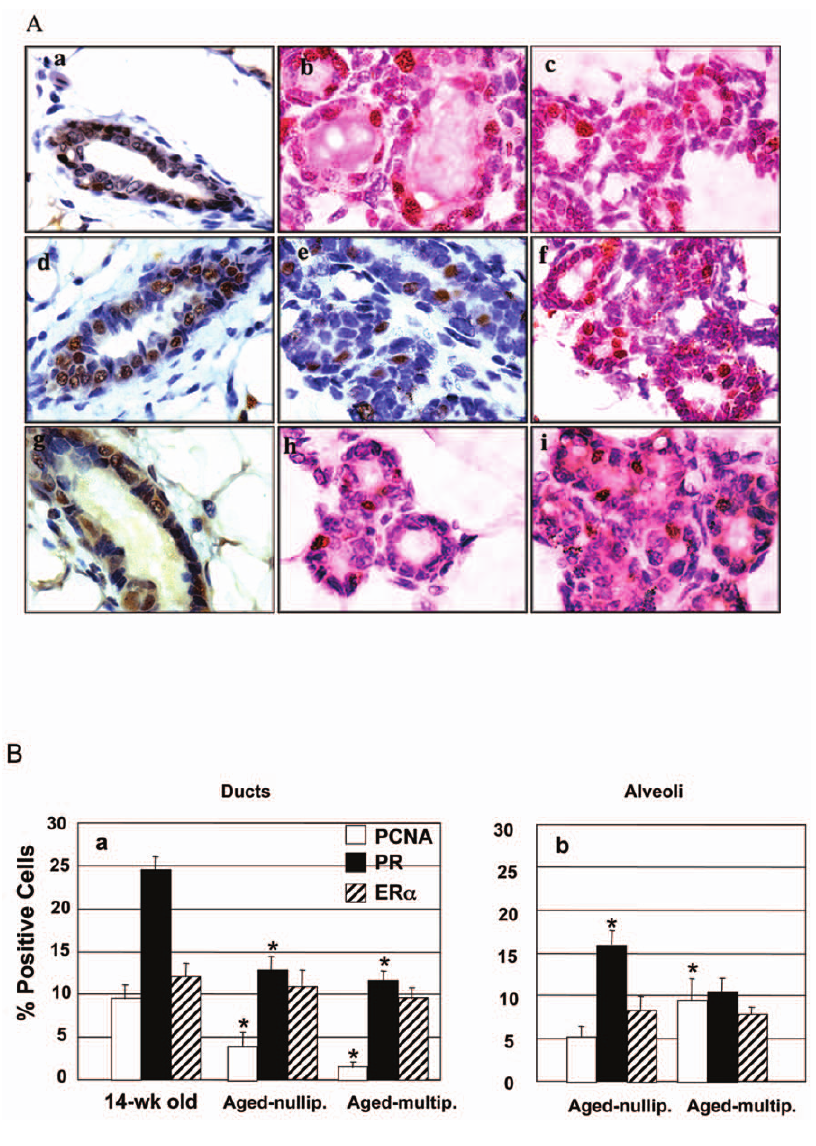
Figure 4. Effect of age and parity on proliferation, progesterone receptor and estrogen receptor-alpha (ER- a ) levels in FVB/N-RC mice mammary glands. ( A ) Representative immuno-histochemistry sections of mammary tissue collected from 14-wk-old (panels a, d and g), aged-nulliparous (panels b, e and h) and aged-multiparous (panels c, f and i) female mice. Tissue was fixed and processed for age and parity associated proliferation marked by PCNA expression (Fig. 4A panels, a–c), progesterone receptor (Fig. 4A panels, d–f) and ER- a (Fig. 4A panels, g–i). Magnification 100 6 . ( B ) Proliferation, progesterone receptor and ER- a percent positive cells were scored and labeling index expressed as a percentage of positive nuclei of at least 3000 counted cells in mammary ducts (Fig. 4B panel a) and alveoli (Fig. 4B panel b). In the ducts, proliferation was significantly lower in the aged-nulliparous ( p , 0.05) and the aged-multiparous ( p , 0.05) mice than the 14-wk-old nulliparous mice. Also, proliferation was significantly lower ( p , 0.05) in the aged-multiparous than in the aged nulliparous mice mammary ducts. Progesterone receptor positive cells were significantly less in the ducts of the aged-nulliparous ( p , 0.05) and the aged-multiparous ( p , 0.05) mice than in the ducts of the 14-wk-old nulliparous mice. In the alveoli, proliferation was significantly higher in the aged-multiparous mice than in the aged-nulliparous ( p , 0.05). Also, progesterone receptor was more prevalent in the alveoli of the aged-nulliparous than in the aged-multiparous ( p , 0.05) mice mammary glands. In Figure 4B * indicates a statistically significant difference of p ,